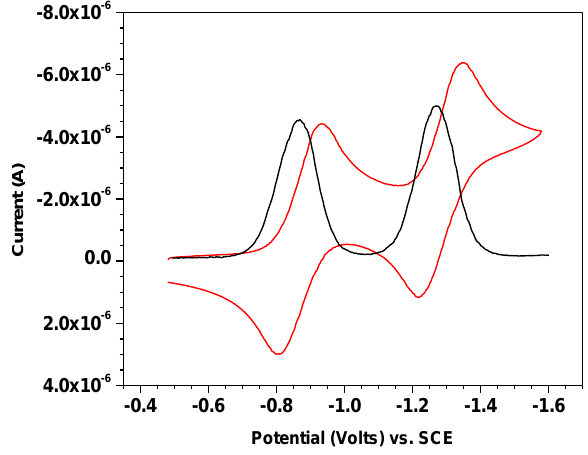
Figure 1. Cyclic voltametry (CV) and differential pulse voltametry (DPV) of 11 + BPh 4− in acetonitrile, referenced to SCE via internal reference ferrocene (not shown).